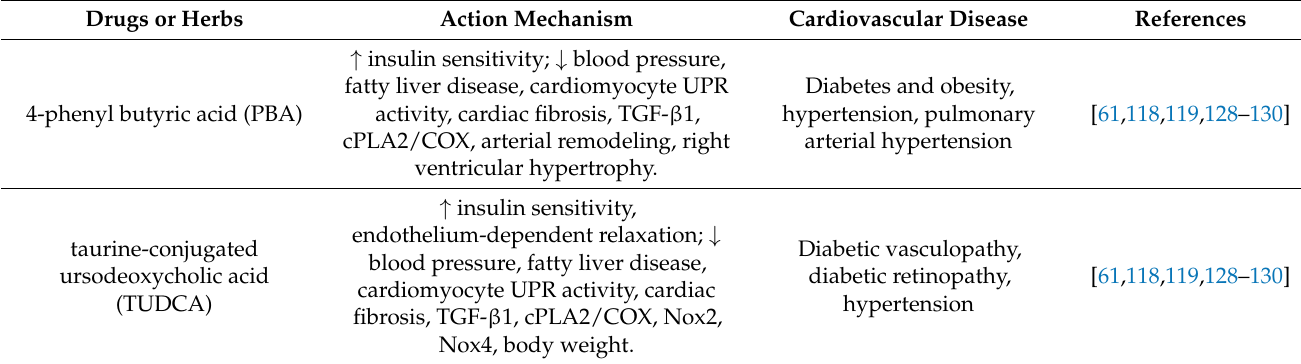
Table 1. Drugs or herbs affecting endoplasmic reticulum stress to ameliorate cardiovascular diseases. Drugs or